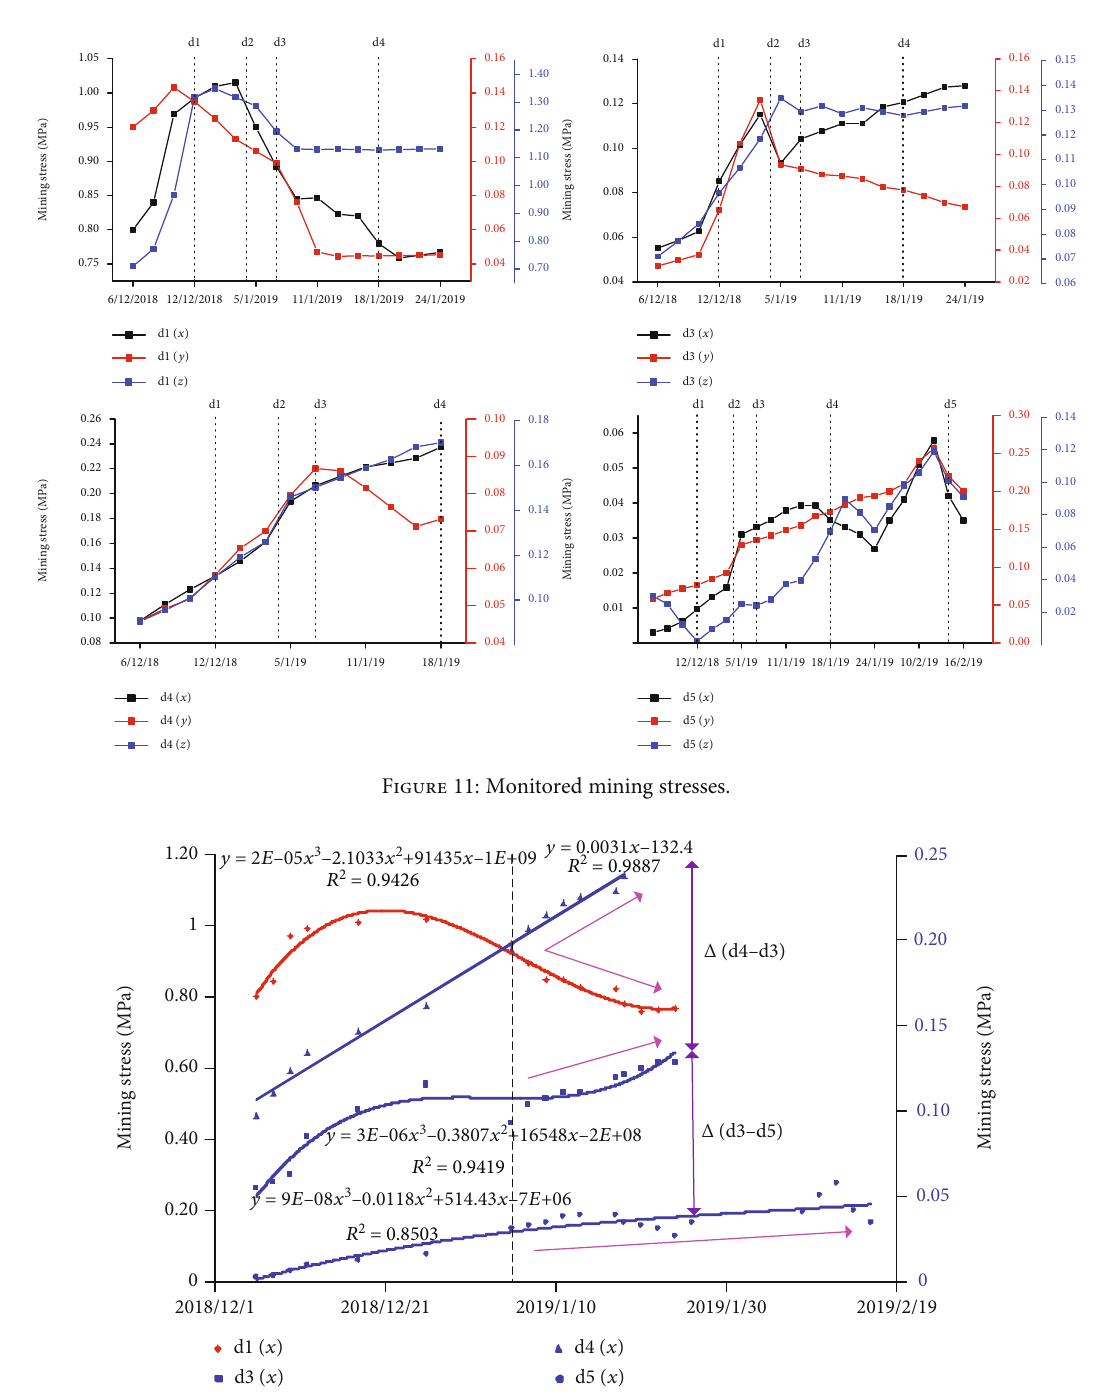
Figure 12: Monitored mining stresses along the roadway. Table 5: The linear relationship of mining stress variation with